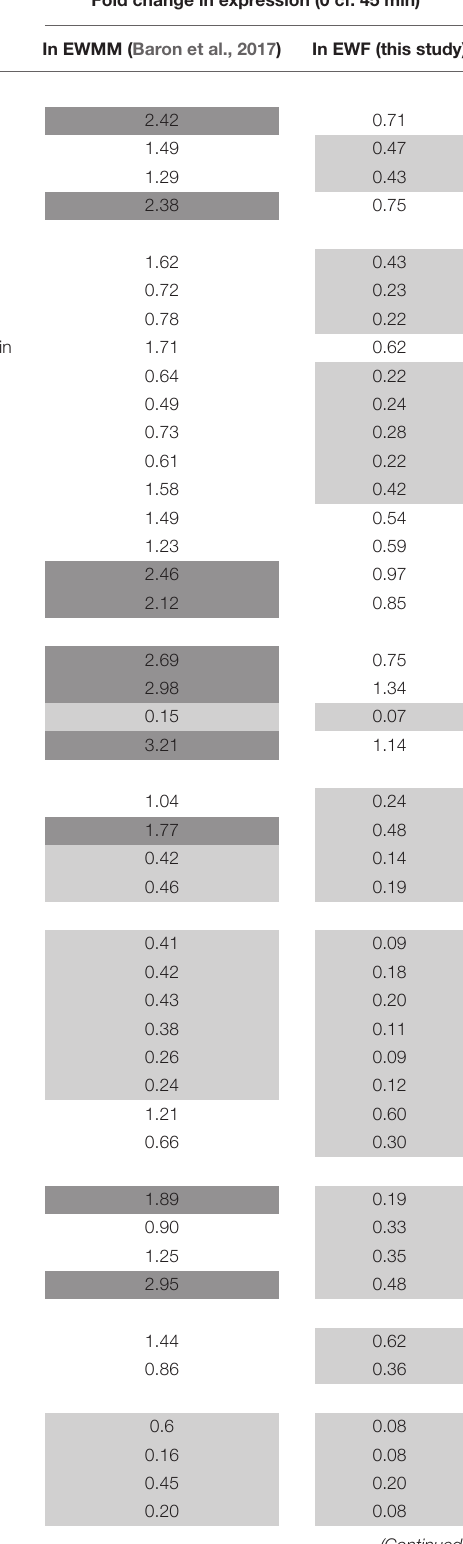
TABLE 2 | Genes of S. Enteritidis differentially expressed in EWMM (with EW proteins) and in EWF (free of EW proteins of > 10 kDa). Gene Function Fold change in expression (0 cf. 45 min) In EWMM (Baron et al., 2017) In EWF (this